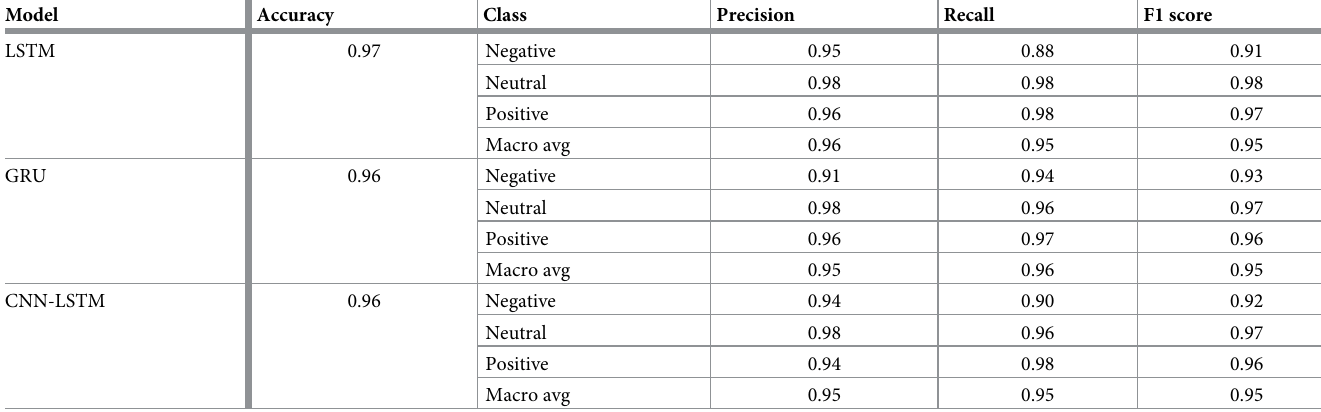
Table 6. Experimental results of deep learning classifiers in sentiment classification of tweets.